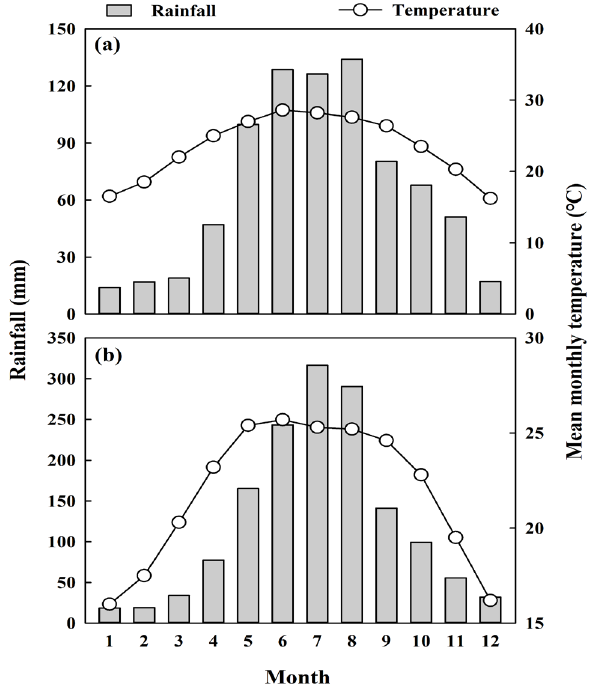
Figure 1. Monthly mean rainfall and temperature of Yuanjiang Savanna Valley ( a ) and Xishuangbanna Tropical Rainforest ( b ), Yunnan, SW China. Data from Yuanjiang Meteorological Station (396 m elevation) and Xishuangbanna Tropical Rainforest Ecosystem Station (570 m elevation), respectively.